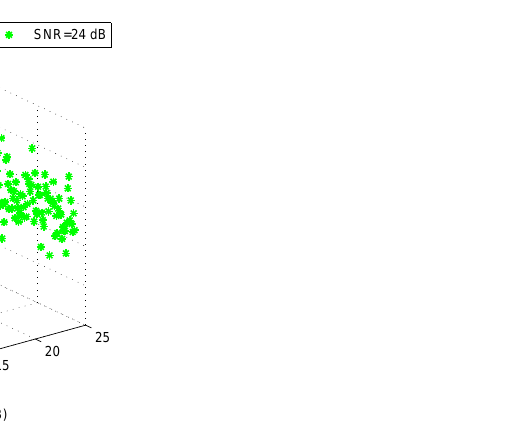
Figure 7. Behavior of the distributions of estimated NMSE using the CIM-LLAD method in system I.